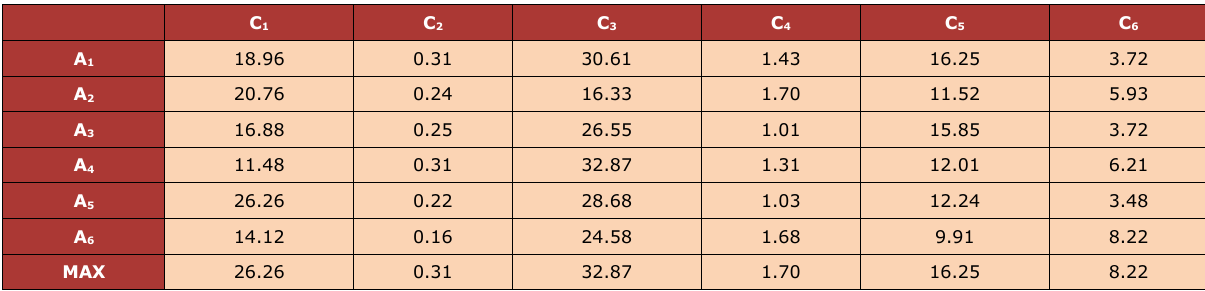
Table 7. Decision matrix of GTMA